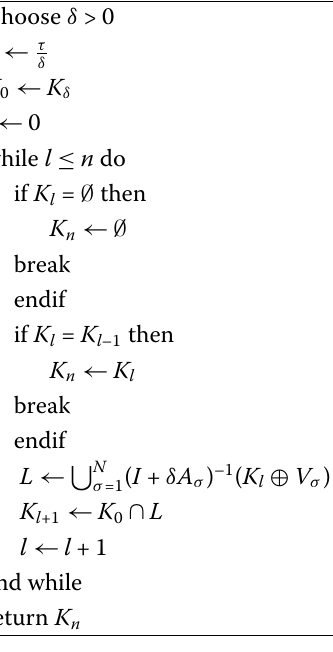
Algorithm 4 The viability kernel of continuous-time switched linear